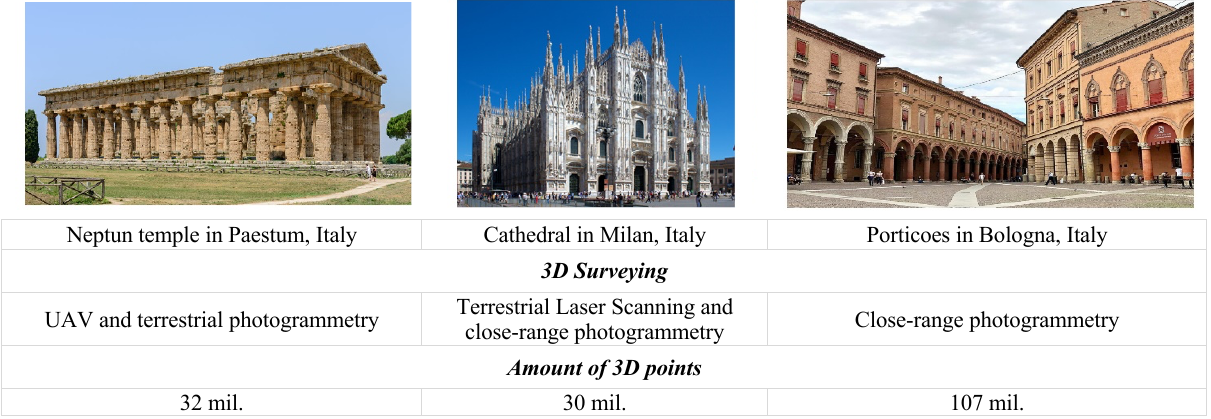
Figure 2. The large heritage monuments considered in the MR experiments and their